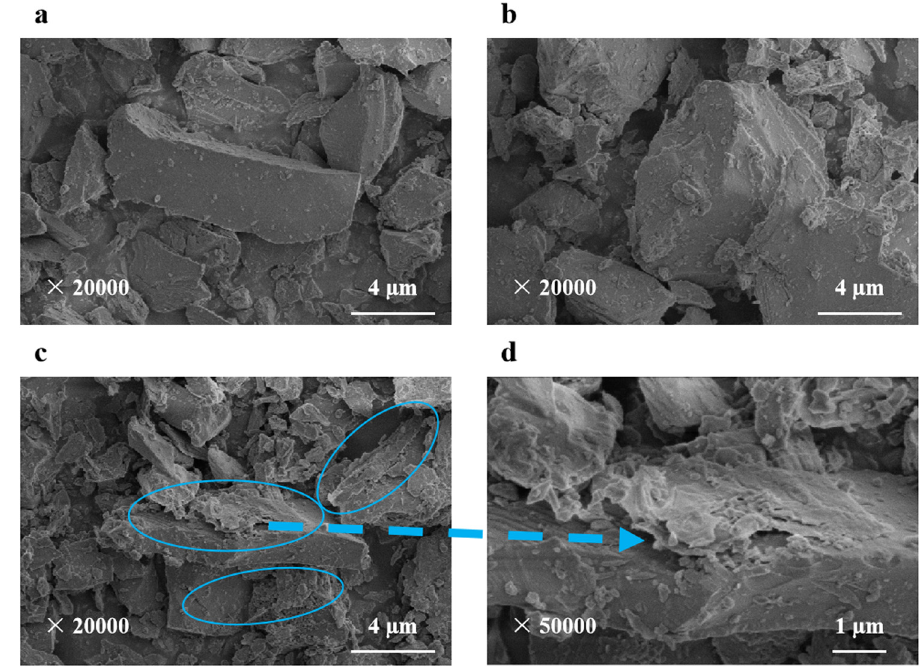
Figure 7: SEM images: ( a ) tourmaline, ( b ) KH - 550 - modi fi ed tourmaline, and ( c and d ) GO/KT